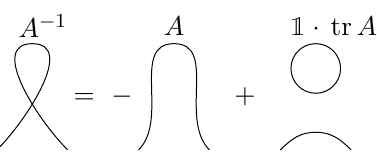
Figure 1 . Geometric interpretation of A + A (cid:0) 1 = 1 (cid:1) tr A